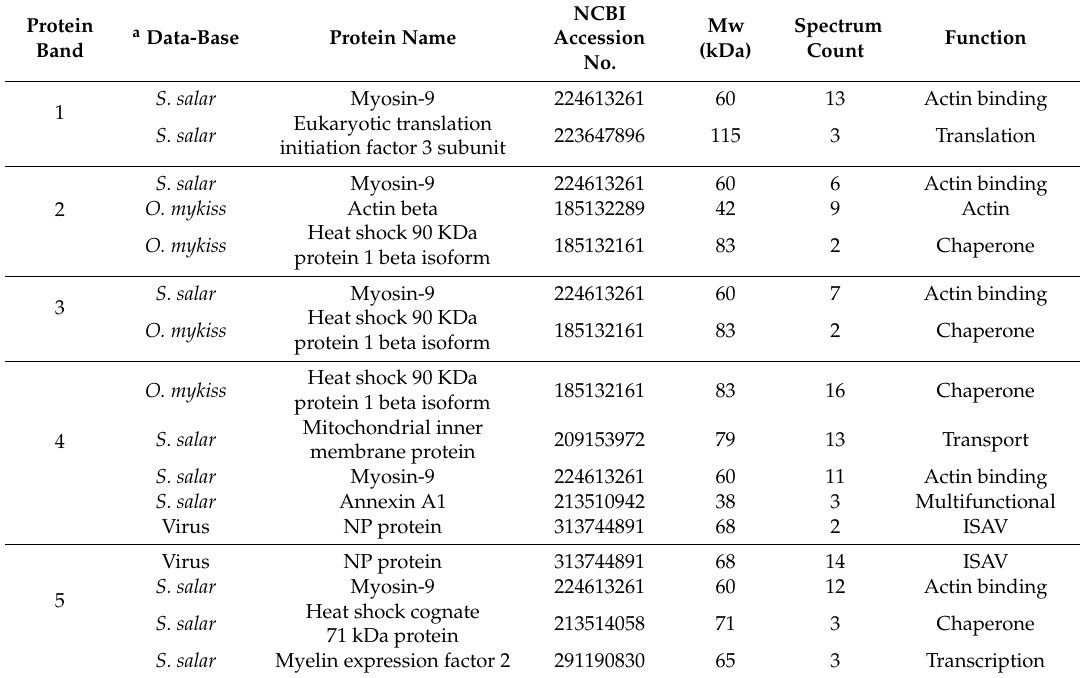
Table 1. LC/MS analysis of excised bands from SDS-PAGE.